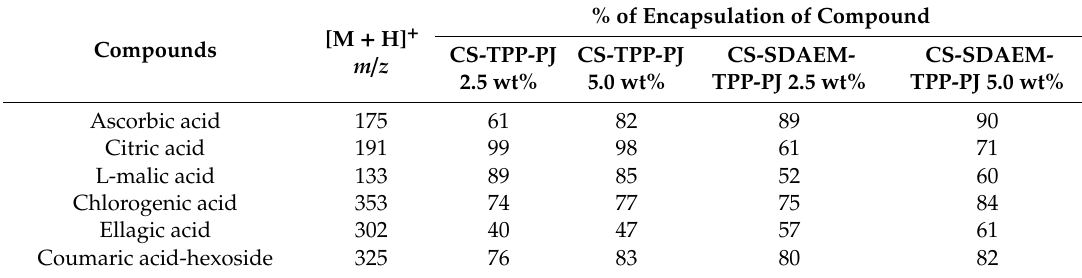
Table 4. Compounds of PJ and their encapsulation e ffi ciency in CS and CS-SDAEM nanoparticles via negative ionization LC / MS [ESI